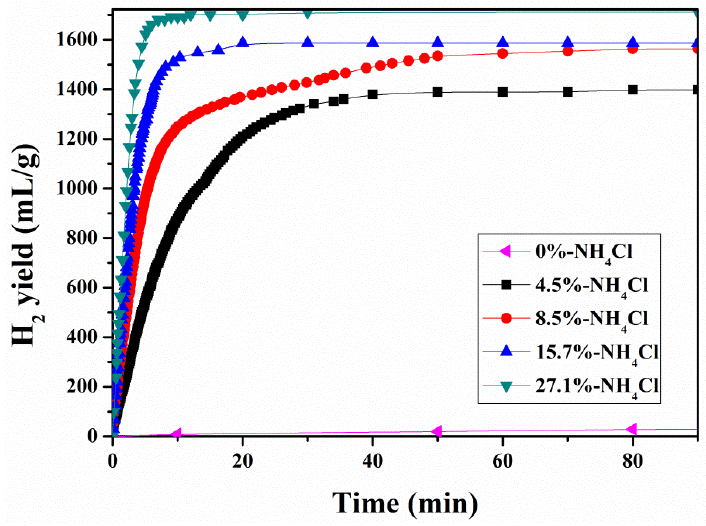
Figure 8. The hydrolysis kinetics of MgH 2 in different concentrations of ammonium chloride